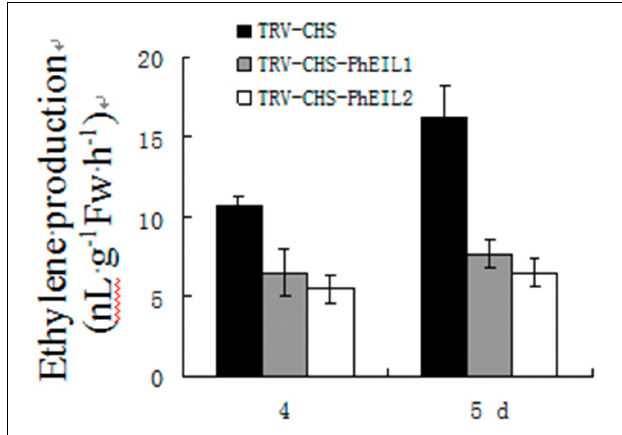
FIGURE 4 | Ethylene productions in PhEIL1 and PhEIL2 silencing flowers. Ethylene production was measured for flower corollas after the flowers were open for 4 and 5 days. Ethylene was collected for 2 h and subsequently measured using a gas chromatograph. Ethylene production rates were calculated based on tissue FW. Mean ± SE values were determined from five samples. Statistical analysis was performed using one way analysis of variance (ANOVA) followed by Duncan’s multiple range test (DMRT) with three